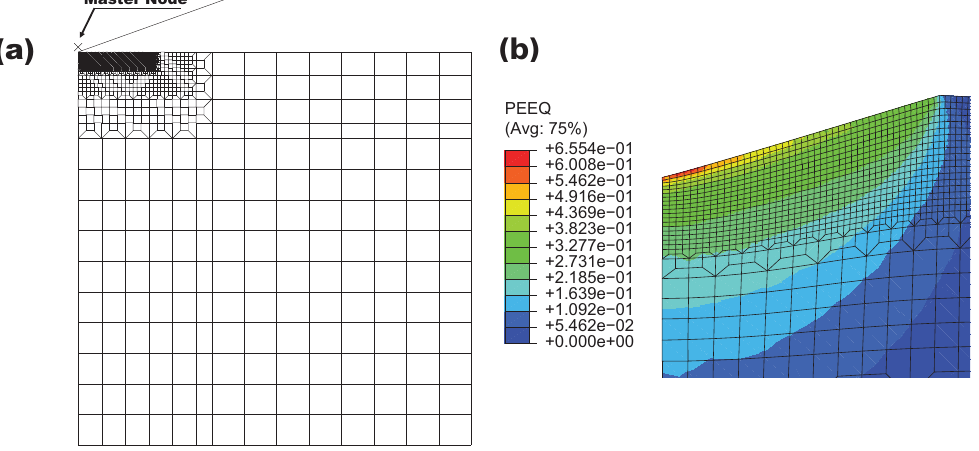
Figure 2. ( a ) axisymmetric finite-element model with a conical indenter for the nanoindentation simulation; ( b ) contour plot of the equivalent plastic strain (PEEQ) within the α phase layer near the tip of the conical indenter after